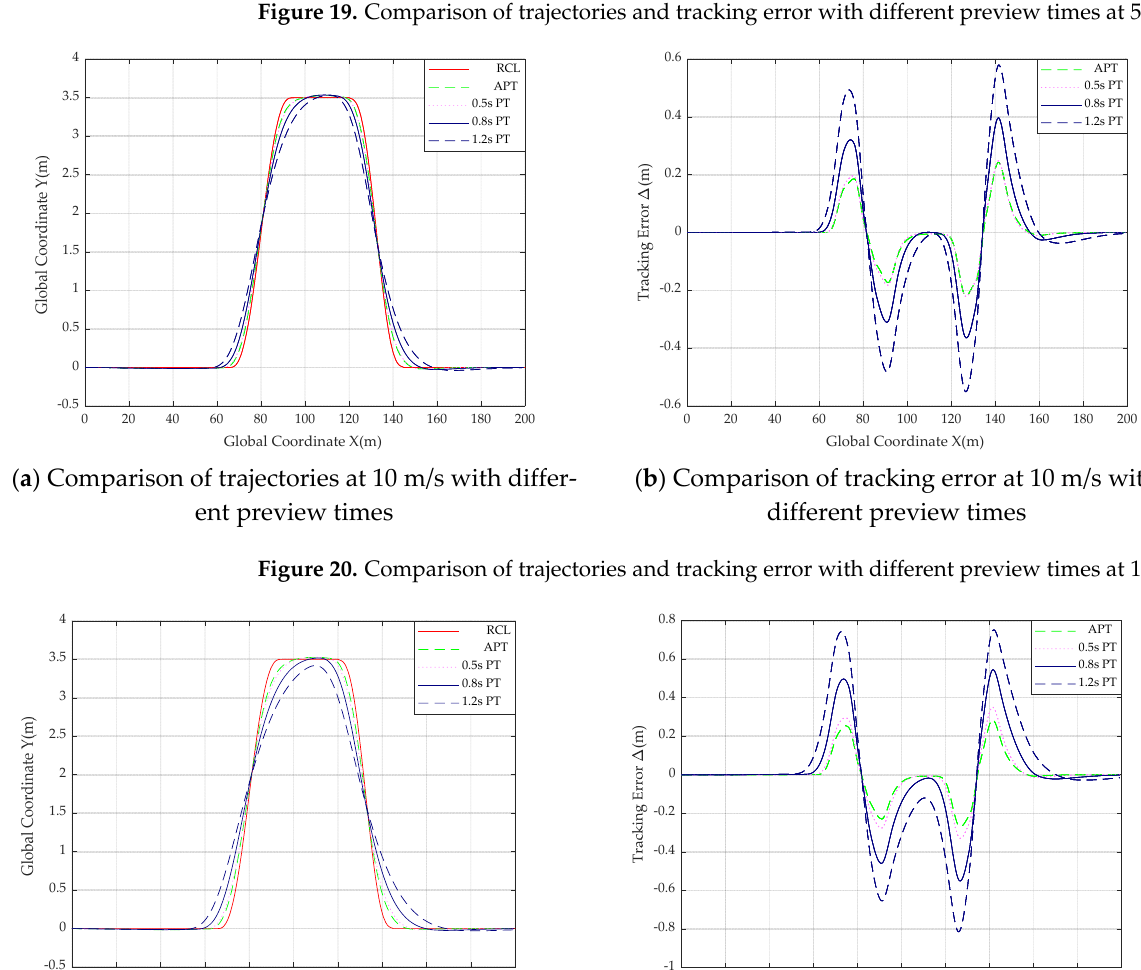
Figure 19. Comparison of trajectories and tracking error with different preview times at 5 m/s.